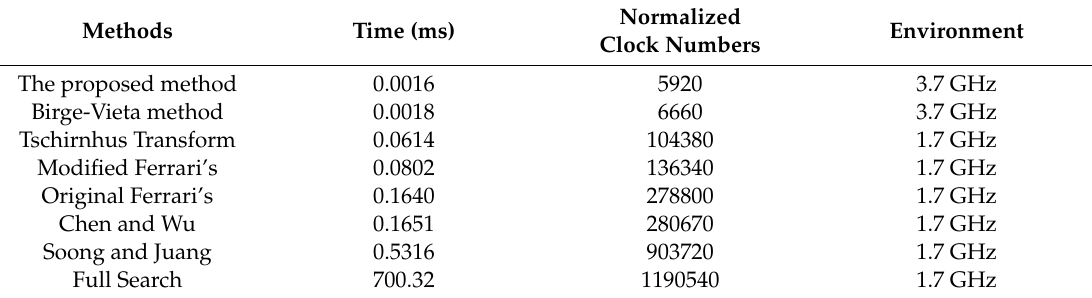
Table 9. Comparison of the average computation time with the previous works ( α =